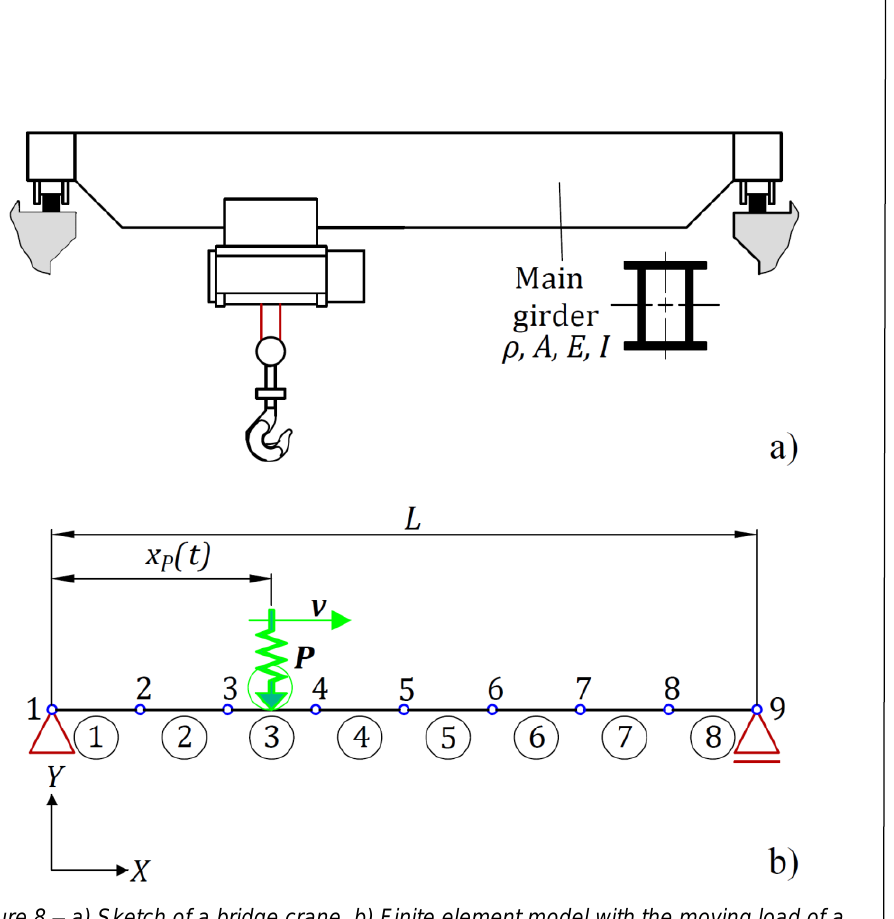
Figure 8 – a) Sketch of a bridge crane, b) Finite element model with the moving load of a bridge